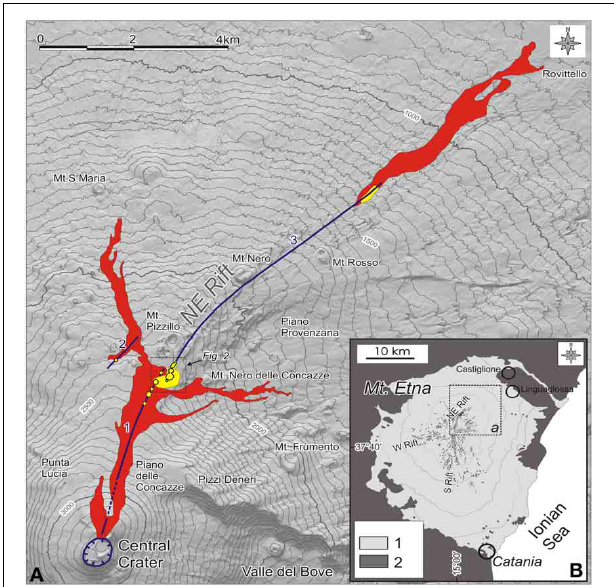
FIGURE 1 | Map of the 1809 eruption, which affected the NE Rift of Mt. Etna volcano (modified after Gemmellaro, 1860; Garduño et al., 1997; Branca et al., 2011). Most portions of the higher (between 3300 and 2500m asl) and lower (between 1300 and 750m asl) lava flows are today buried by younger volcanic products. (A) The lava flows are shown in red. The eruptive fissures are indicated in blue and numbered 1 to 3 from top to bottom, according to the chronology of opening. Yellow areas highlight the main cinder cones and explosive vents (see text for details). Contour lines are in metres. (B) The main rift zones of Etna and the location of the studied area. 1. volcanics; 2. sedimentary